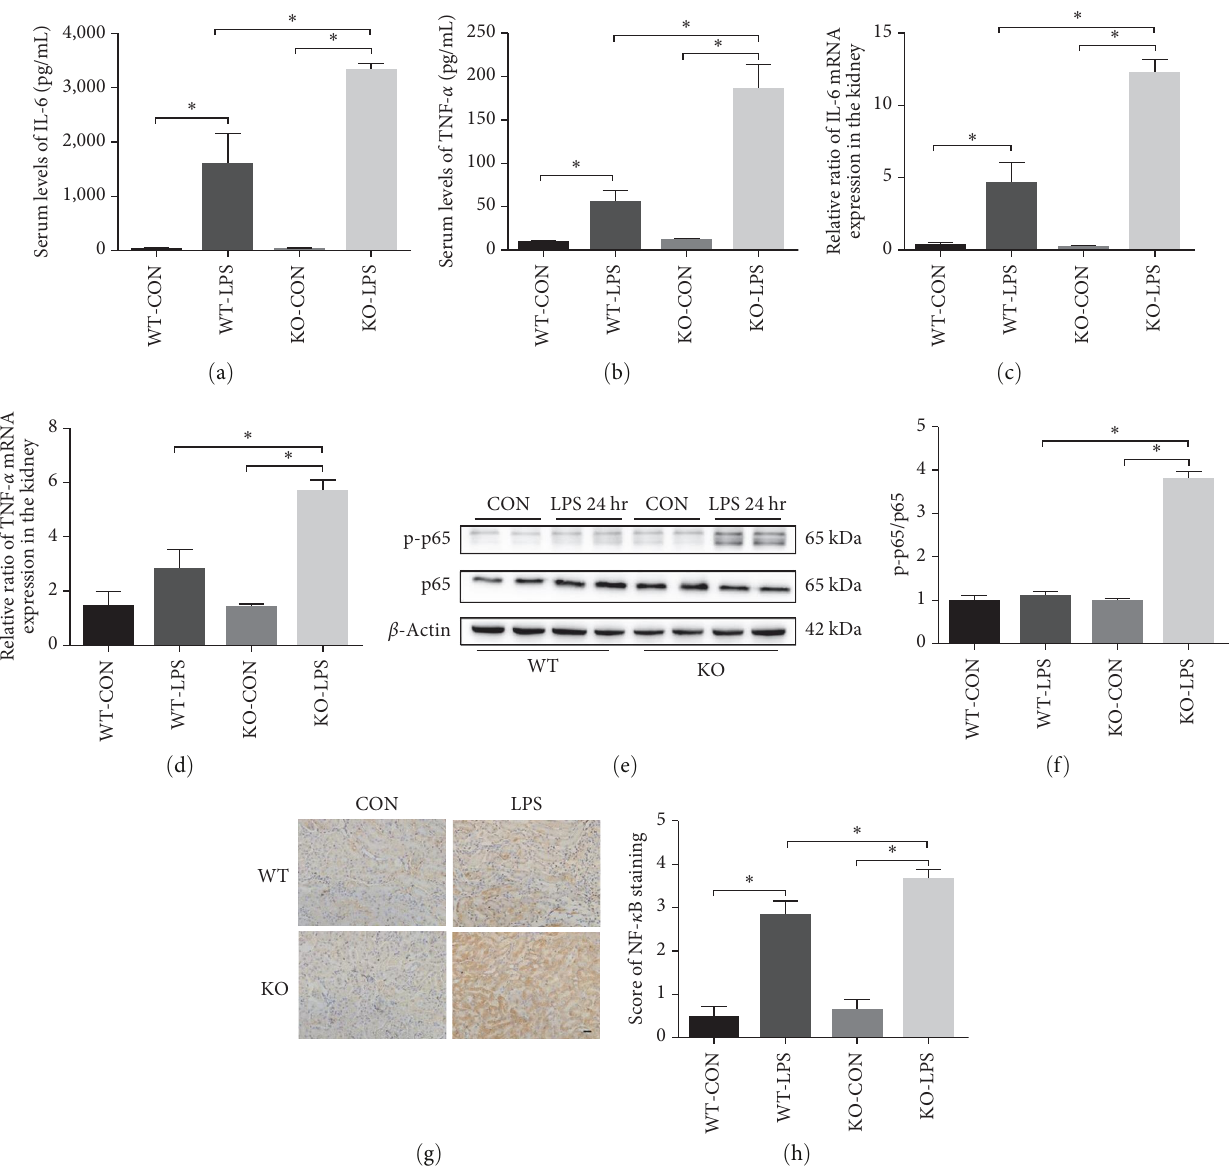
F IGURE 3: Role of ALDH2 on the LPS-induced in fl ammatory response and NF- κ B activation: (a, b) protein levels of interleukin (IL)-6 and tumor necrosis factor (TNF)- α in the kidney homogenate were measured using ELISA; (c, d) mRNA levels of IL-6 and TNF- α were measured by PCR analysis in the kidney homogenate; (e, f) representative western blots and quanti fi cation analysis of NF- κ B expression and β -actin; (g) immunohistochemical staining for NF- κ B expression in kidneys in WT and KO mice after LPS administration; (h) quanti fi cation of NF- κ B positive cells per fi eld. Scale bars: 50 μ m. All data are expressed as mean Æ SEM ( n = 6). ∗ P < 0 :